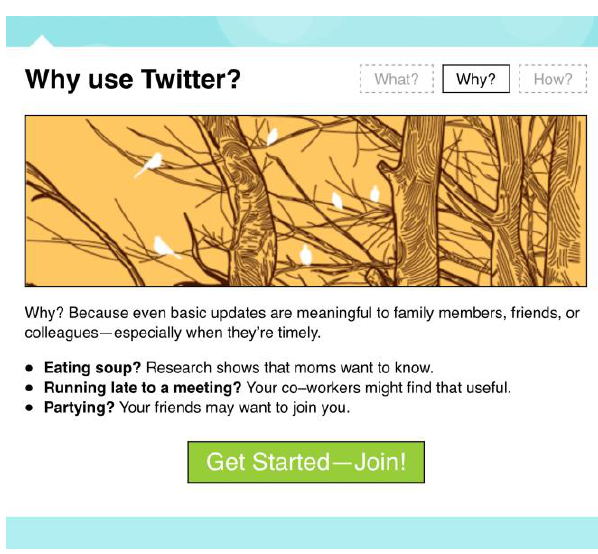
Figure 2. A screenshot from the “Why use Twitter?” page, 2 November 2007 [60].